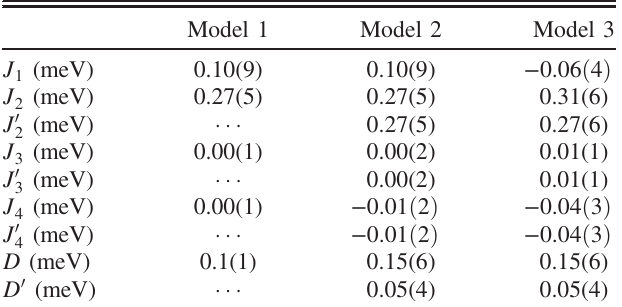
VII. Basis vectors for the space group I k ¼ ð 001 Þ for for the Fe site (0,0,0). Irrep.